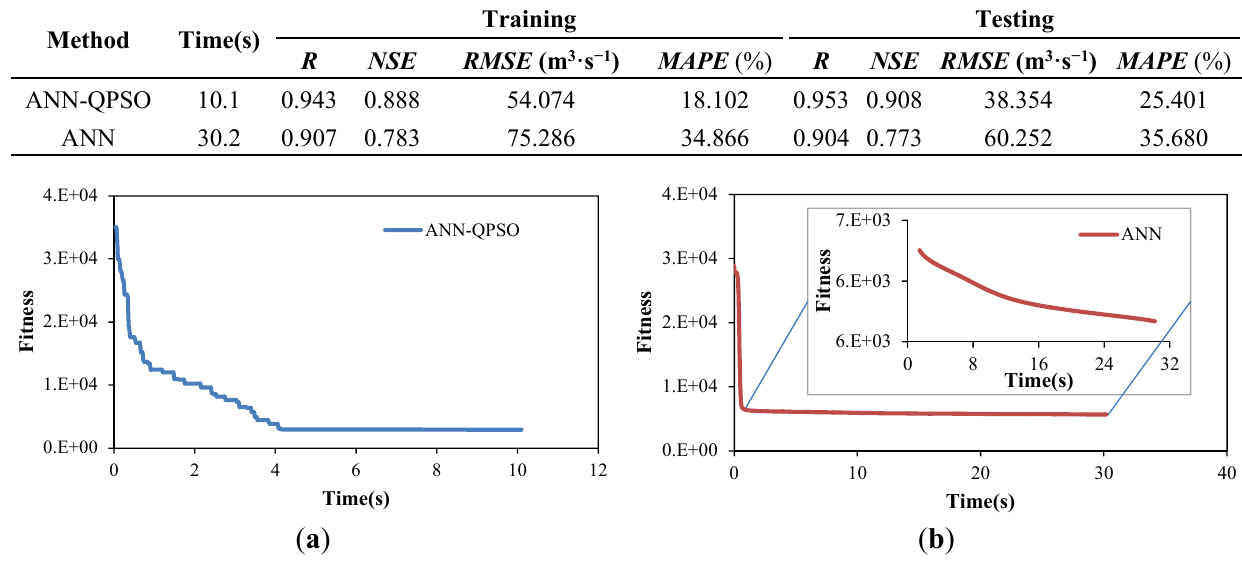
Figure 5. Convergence characteristic of the objective function of two methods for Hongjiadu reservoir ( a ) ANN-QPSO; ( b ) ANN.